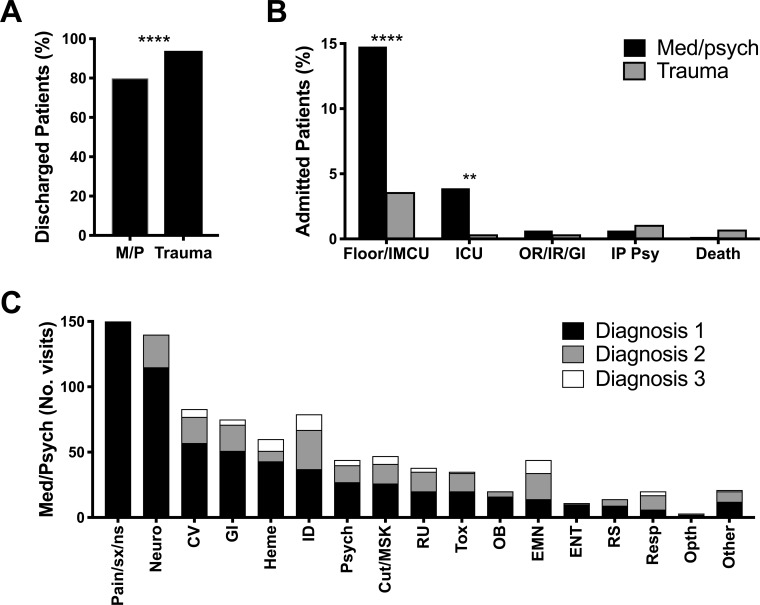
Patients presenting with medical or psychiatric complaints were more likely to require hospital admission than patients presenting with trauma-related complaints.We quantified the percent of incarcerated patients presenting to a tertiary care, academic emergency department between January 2012 and December 2014 who were discharged to the correctional facility of origin (A) or admitted to the hospital (B). Primary, secondary, and tertiary discharge diagnoses were quantified for patients presenting with a medical or psychiatric chief complaint (C). Shown in percent (%) or absolute number (No. visits) of patient encounters as indicated. Cut, cutaneous; CV, cardiovascular; EMN, endocrine/metabolic/nutrition; ENT, ear/nose/throat; GI, gastroenterology; Heme, hematologic; ICU, intensive care unit; ID, infectious disease; IMCU, intermediate medical care unit; IP Psy, inpatient psychiatric facility; IR, interventional radiology; M/P, medical or psychiatric chief complaint; Med, medical; MSK, musculoskeletal; Neuro, neurologic; OB, obstetric; Opth, ophthalmology; OR, operating room; Psych, psychiatric; Resp, respiratory; RS, reproductive system; RU, renal/urinary; Tox, toxicity or intoxication. ** p = 0.003, **** p < 0.0001.